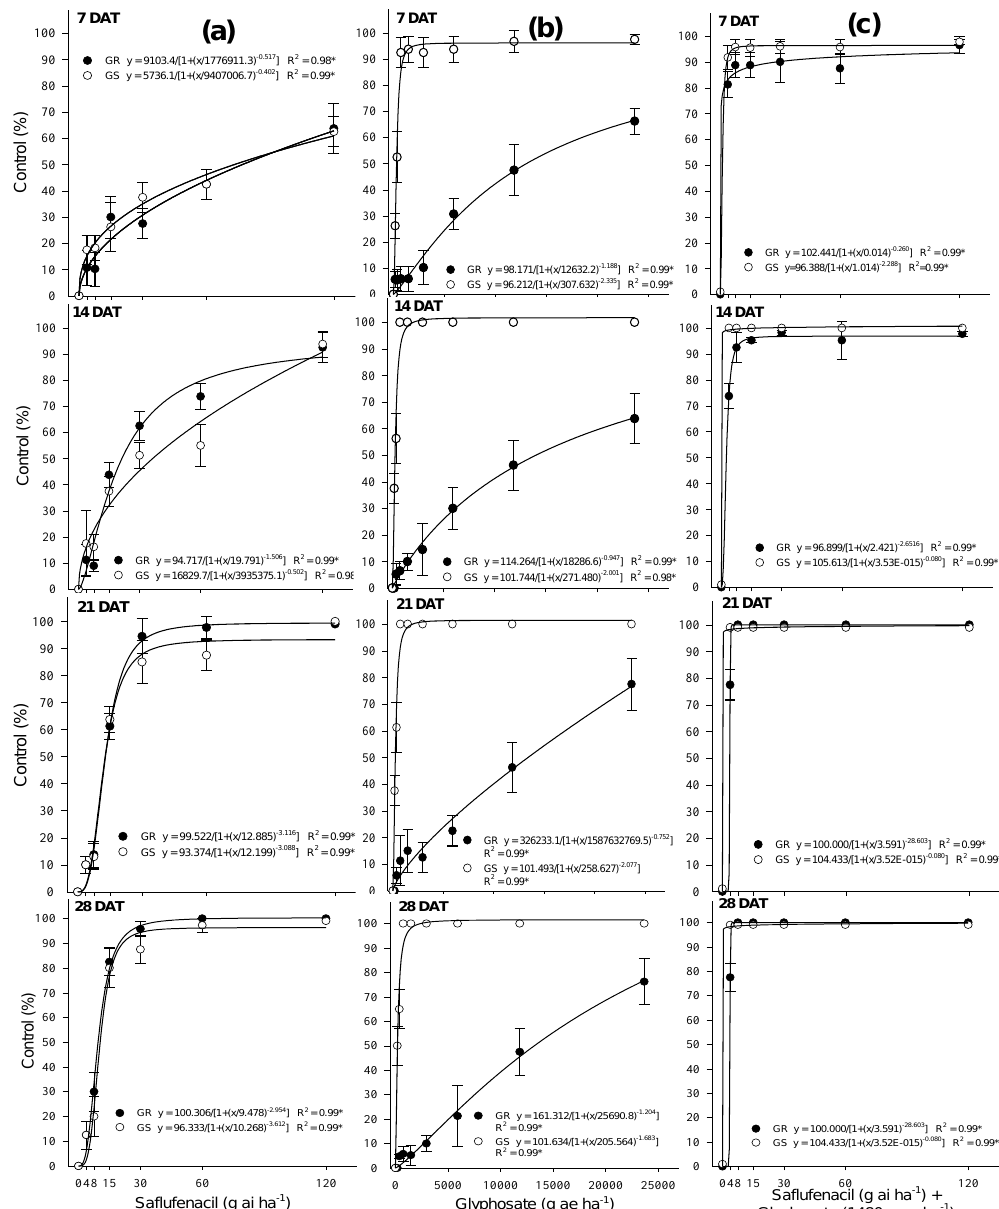
Figure 2. Control of glyphosate-resistant (GR) and -sensitive (GS) Conyza bonariensis biotypes at 7, 14, 21, and 28 days after treatment (DAT) with ( a ) saflufenacil at 0, 3.75, 7.5, 15, 30, 60, and 120 g ha − 1 , ( b ) glyphosate at 0, 185, 370, 740, 1480, 2960, 5920, 11,840, and 23,680 g ae ha − 1 , and ( c ) glyphosate at 1480 g ae ha − 1 combined with saflufenacil rates of 0, 3.75, 7.5, 15, 30, 60, and 120 g ha − 1 . Lines are the response curves predicted from non-linear regression, symbols represent means of three replicates, and bars show the 95% confidence intervals (CI).